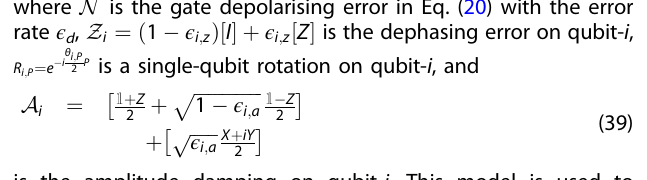
Figure 1(b). The observable is O = P 1 ⊗ P 2 ⊗ ⋯ ⊗ P n , where P = I , Z is taken randomly. All-to-all-network circuits. It is similar to linear-network